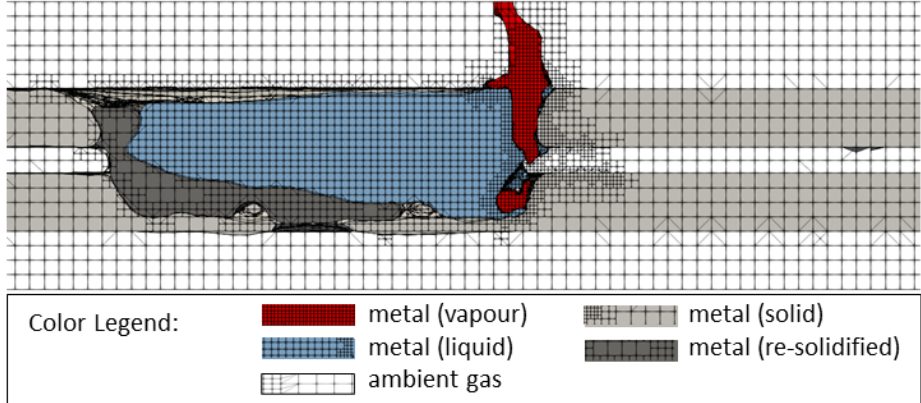
Figure 2. Refined computational grid during simulation S5 at time t = 60